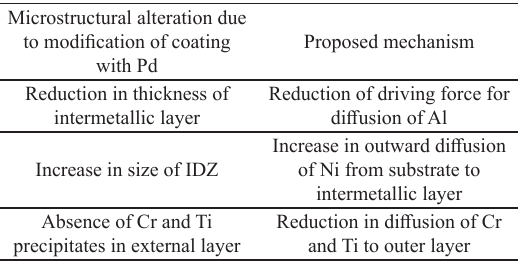
Table 5. Microstructural alterations due to modification of aluminized coatings with Pd and the proposed